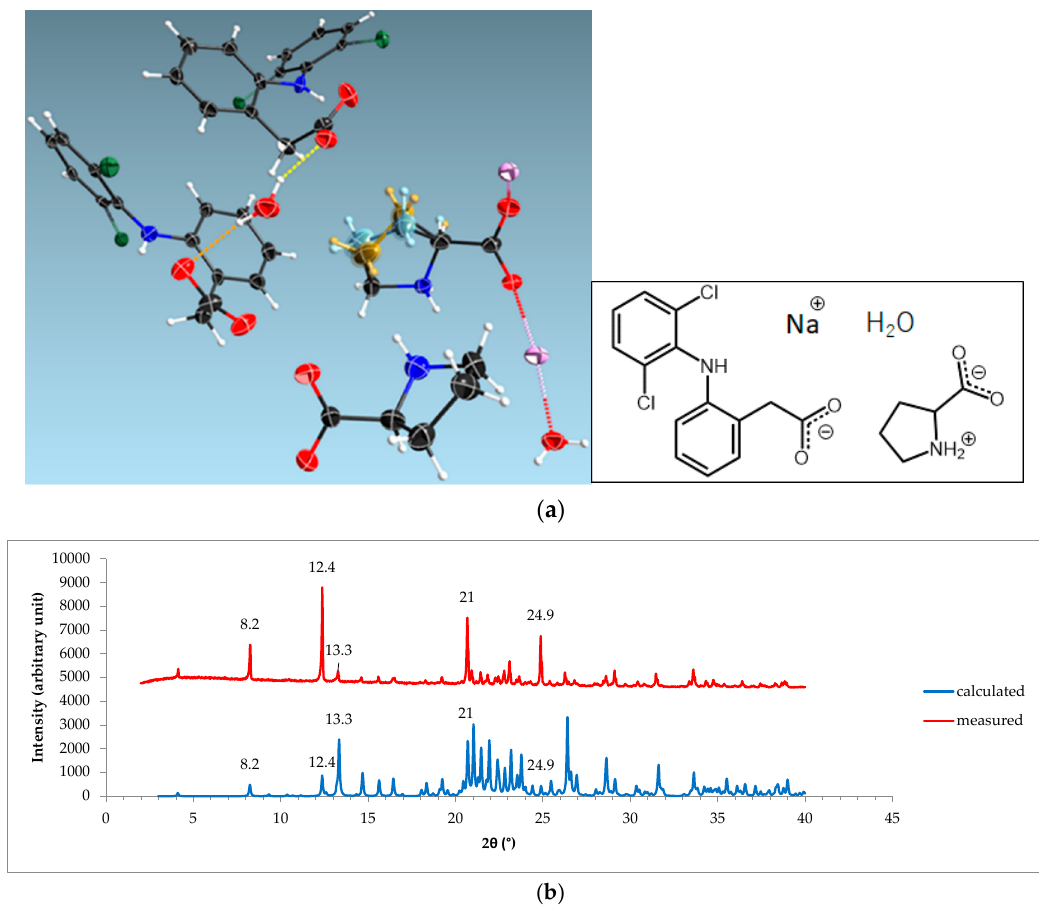
Figure 12. ( a ) ORTEP cell view and molecular structure graph of NDPM; Na + is in violet. ( b ) The measured and calculated diffractograms of NDPM.